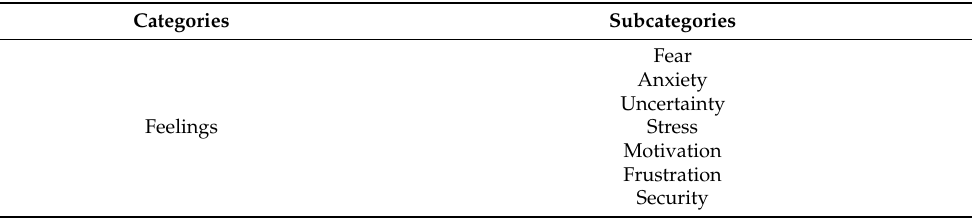
Table 3. Categories and subcategories